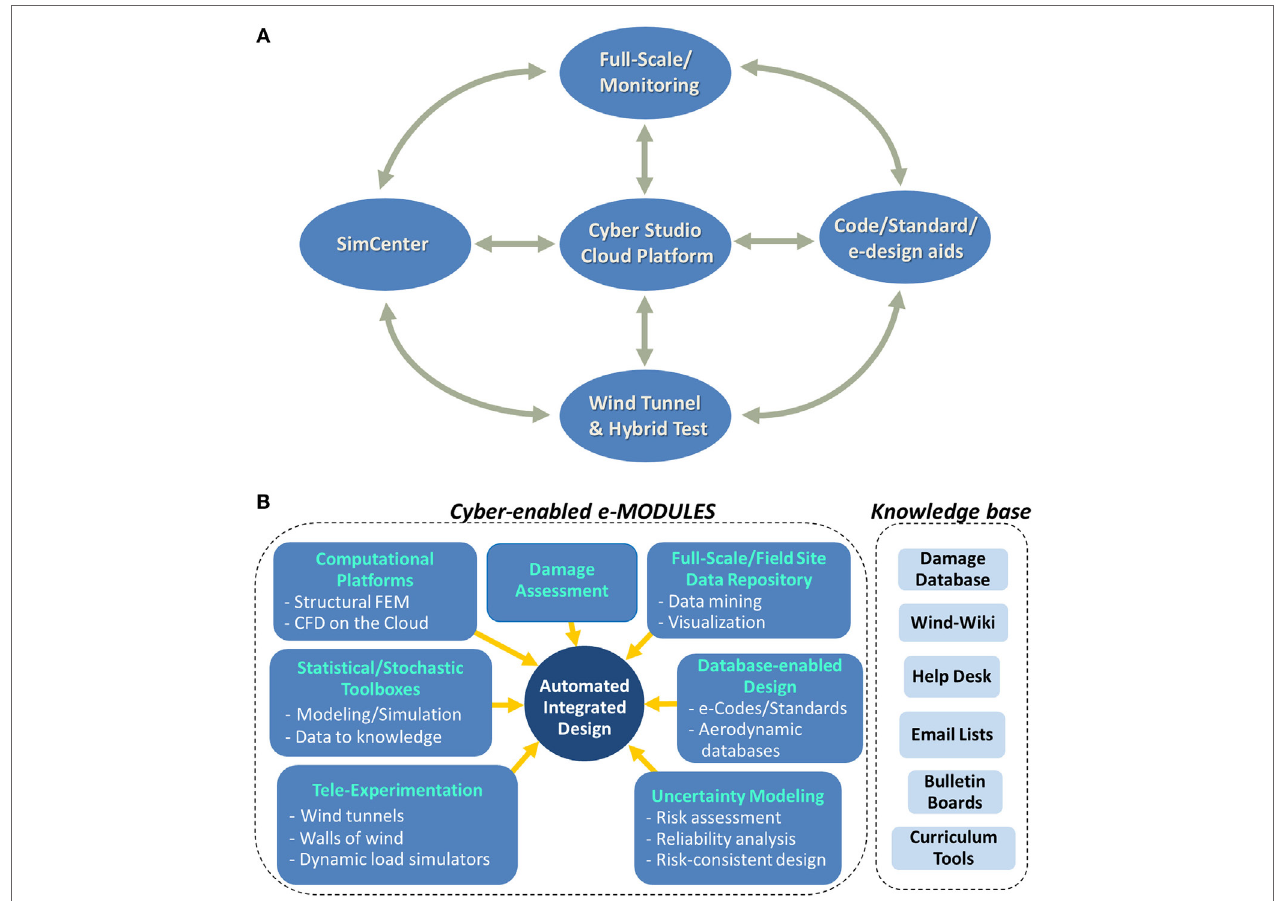
FigUre 1 | (a) Modeling wind effects. (B) Schematic of VORTEX-Winds